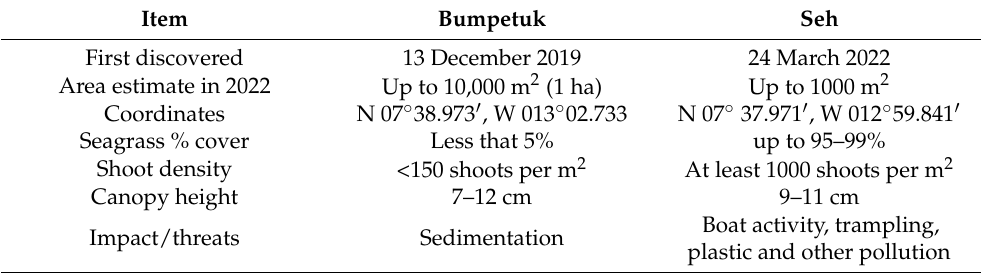
Figure 10. High and low density of seagrass meadow at Seh (left) and Bumpetuk (right), Photo:SB). Table 4. Overview of the seagrass meadows in Sierra